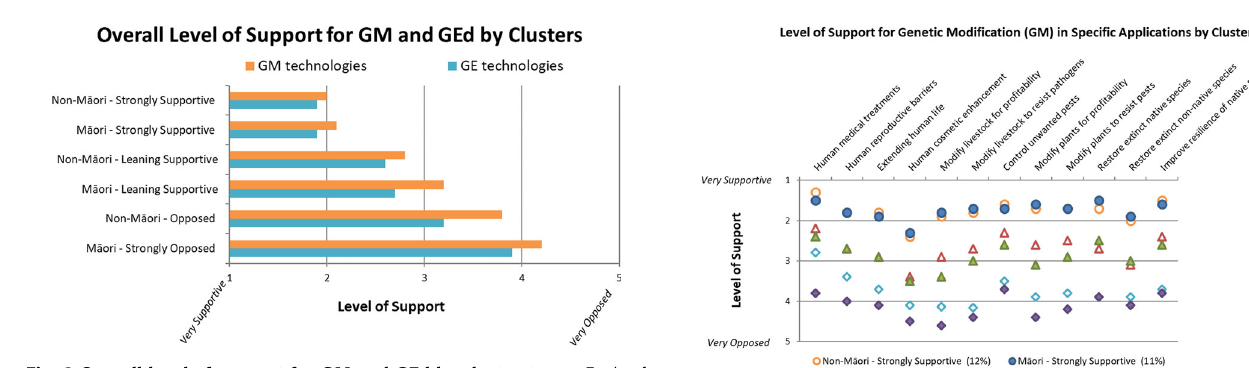
Fig. 2 Overall level of support for GM and GEd by cluster types. Each of the six cluster typologies, regardless of overall perspective on gene technologies, was more supportive of GEd technologies than GM technologies.